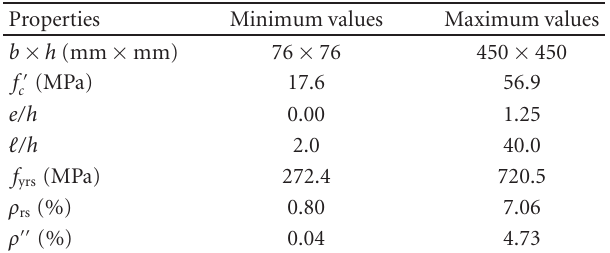
Table 1: Summary of geometric and material properties of rein- forced concrete column specimens a .